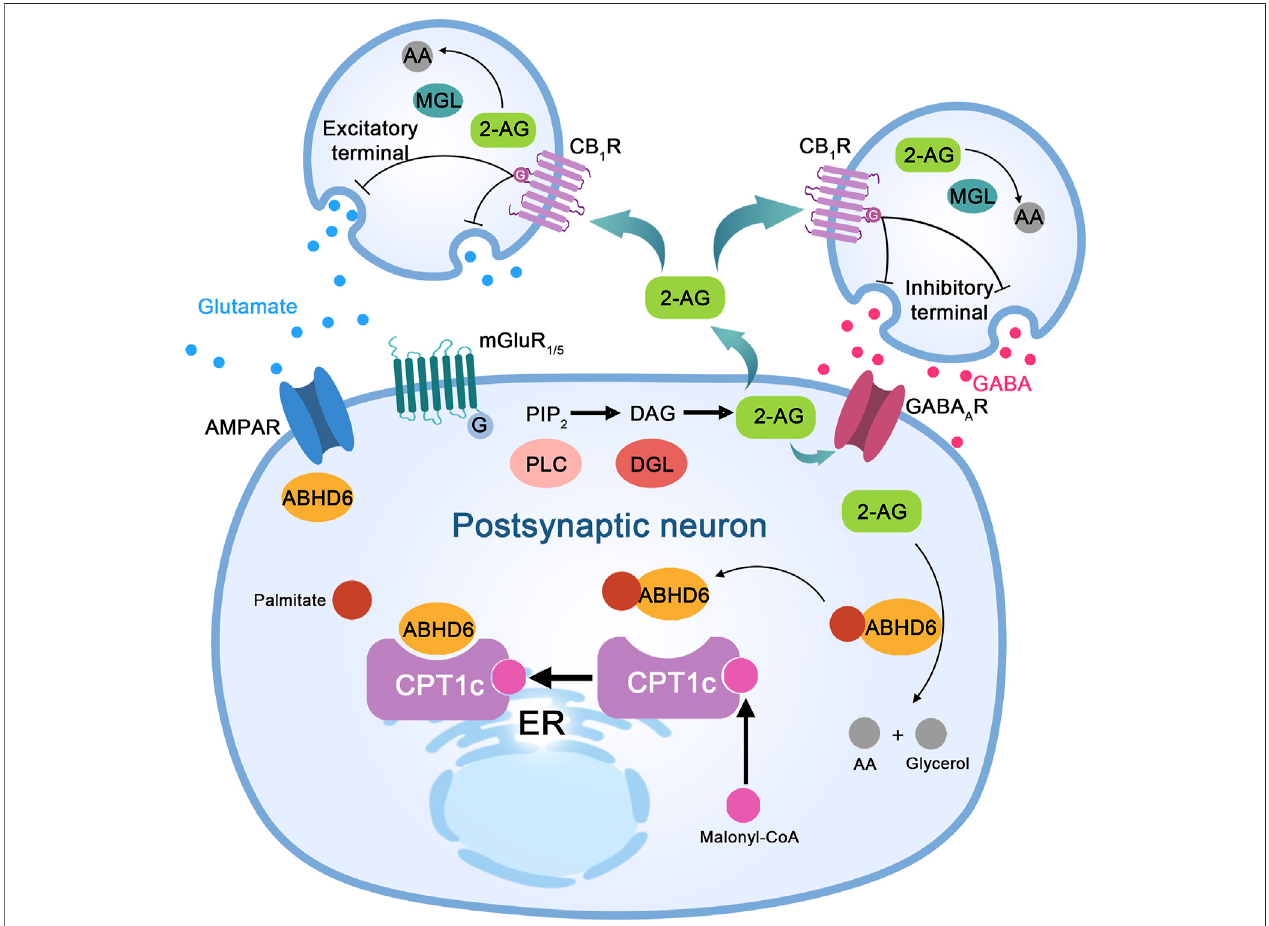
FIGURE2| Theproposed molecular mechanism ofABHD6 inneuronsand neurological diseases.Stimulation ofexcitatory neuronsto release glutamate activates metabotropic glutamate receptor 1/5 (mGluR1/5) on postsynaptic neurons, which couples to a G protein, activates phospholipase C (PLC), and leads to diacylglycerol (DAG) production from inositol diphosphate (PIP2). DAG is cleaved by DAG lipase (DGL) to produce 2-arachidonic acid glycerol (2-AG). Its functions are as follows: (I) acting as a paracrine agonist of the CB1 receptor (CB 1 R) expressed at the excitatory end, releasing glutamate to activate mGluR1/5 and α -amino-3-hydroxy-5- methyl-4-isoxazolpropionic acid (AMPA) receptors; (II) CB 1 R paracrine agonists release GABA and activate GABAA receptor (GABAAR) on postsynaptic neurons through inhibitory terminal expression; and (III) autocrine positive allosteric regulators of GABAA receptors in postsynaptic neurons. Monoacylglycerol lipase (MGL) in presynapticneuronsor α / β -hydrolasedomain-containing6(ABHD6)inpostsynapticneuronshydrolyzesexcess2-AGtoarachidonicacid(AA)andglycerol(notshown). ABHD6interactswiththeAMPAreceptorandcontrolsitstransporttothepostsynapticcompartmentmembrane.Bioinformaticanalysisindicatesthepresenceofamino acid sites of palmitoylation/depalmitoylation modi fi cation in ABHD6. Protein interaction between CPT1c and ABHD6 depends on the presence of malonyl-COA; when malonyl-COA is absent, the inhibitory effect of CPT1c on ABHD6 enzyme activity is lost.